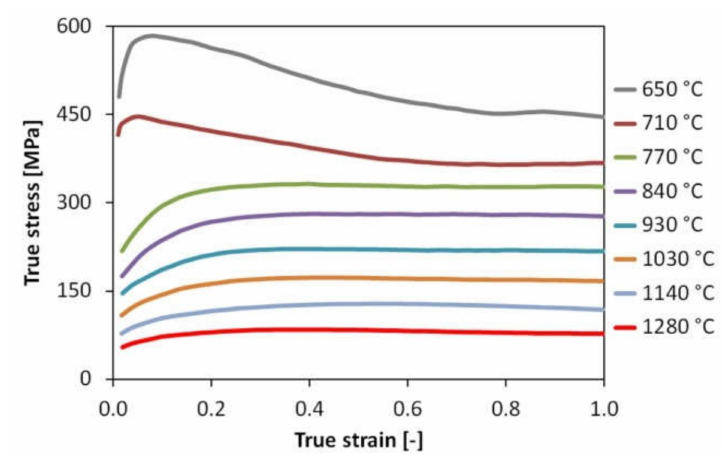
Figure 11. Influence of temperature on flow curves at a nominal strain rate of 20 s − 1 .